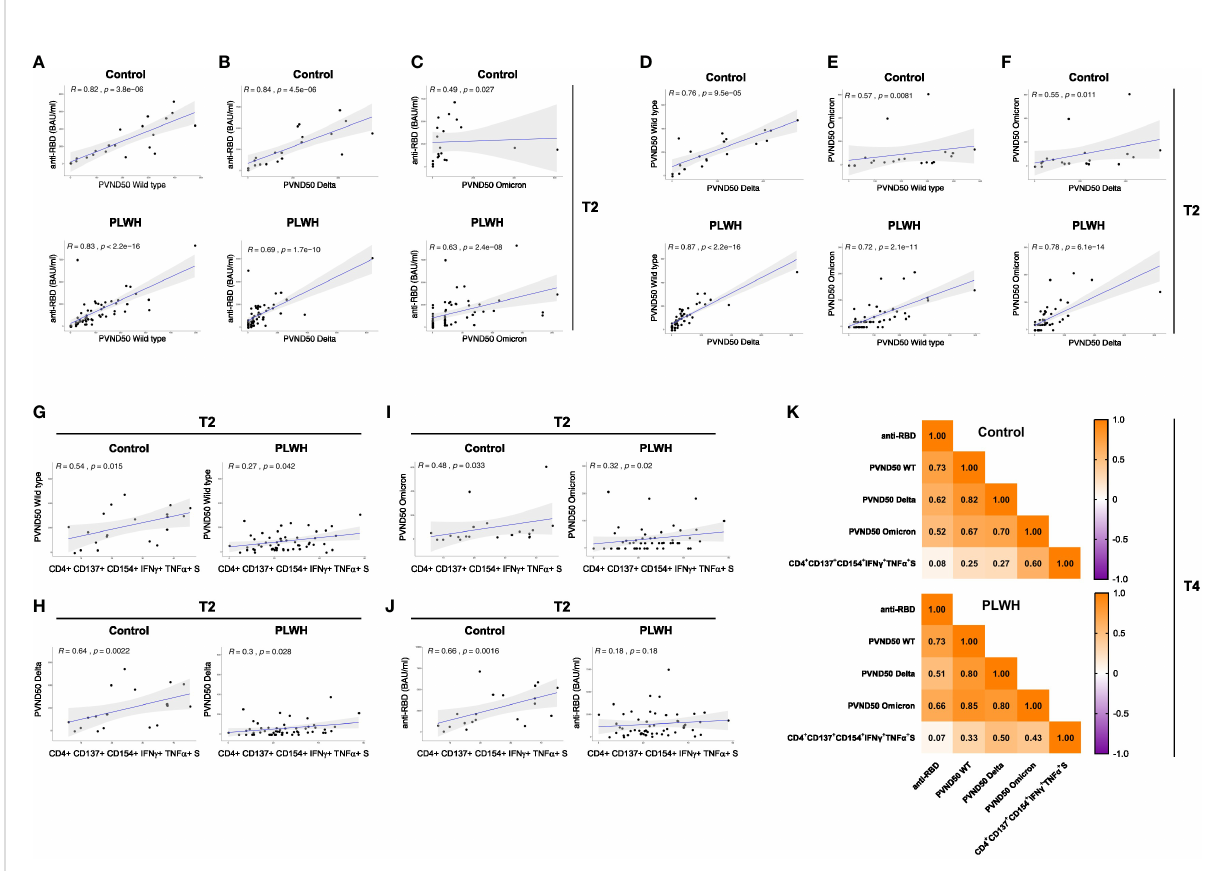
FIGURE 4 Correlation analysis of immune response parameters in vaccinated PLWH and HIV-negative controls. (A-C) The scatter plots represent correlation analyses between anti-RBD titers and neutralizing capacity against the SARS-CoV-2 WT, Delta and Omicron strains for control and PLWH groups. (D-F) The scatter plots represent correlation analyses among the neutralizing capacities against the indicated SARS-CoV-2 strains for control and PLWH groups. (G-J) CD4+ CD137+ CD154+ T cells expressing both IFN g + and TNF a + upon spike protein-derived peptide pool stimulation were correlated using spearman method for time point T2. The scatter plots represent correlation between CD4+ CD137+ CD154+ IFN g + TNF a + T cells and neutralizing capacity against WT strain of SARS-CoV-2 (G) , Delta variant of SARS-CoV-2 (H) , Omicron variant of SARS-CoV-2 (I) and against anti-RBD titers (J) on the left side for controls, while scatter plots on the right side are for PLWH cohort. Black dots represent the values of the individual donors. The regression line is indicated in blue, while the gray area represents the 95% con fi dence interval region. In the graphs, R indicates the correlation coef fi cient and p stands for p-value of statistical signi fi cance. (K) Correlation matrix of the indicated parameters obtained at time point T4. Spearman method was used for correlation analyses. The values of the correlation coef fi cient R is